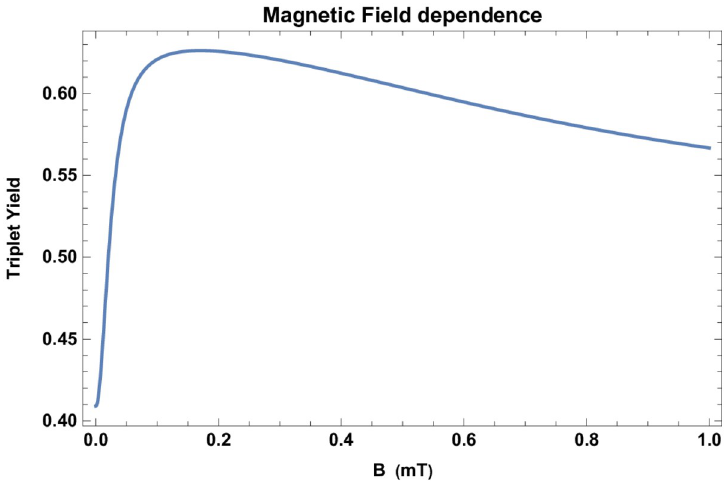
Fig 4. Magnetic field dependence of F ð S Þ . The dependence of the triplet yield of the RPM for singlet-born radical pair T on external magnetic field B for a 1 = − 802.9 μT [47], reaction rate k = 2 × 10 6 s − 1 , and relaxation rate r = 2 × 10 5 s − 1 .